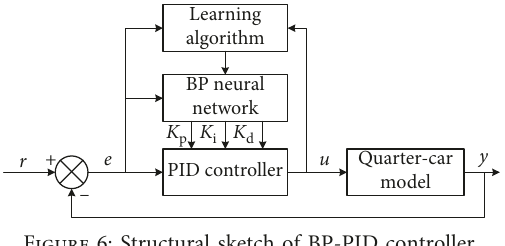
Figure 6: Structural sketch of BP-PID